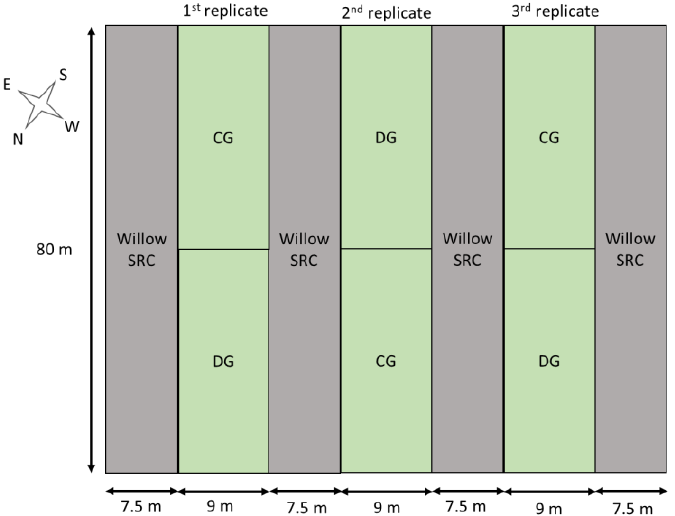
Figure 1. Alley cropping design of agroforestry system with different grassland types (CG = clover grass; DG = diverse grassland mixture) and willow stripes as short-rotation coppice (SRC), 3 replicates in grassland alleyways between the willow stripes. Reference plots of grassland and willow SRC were located at adjacent areas.